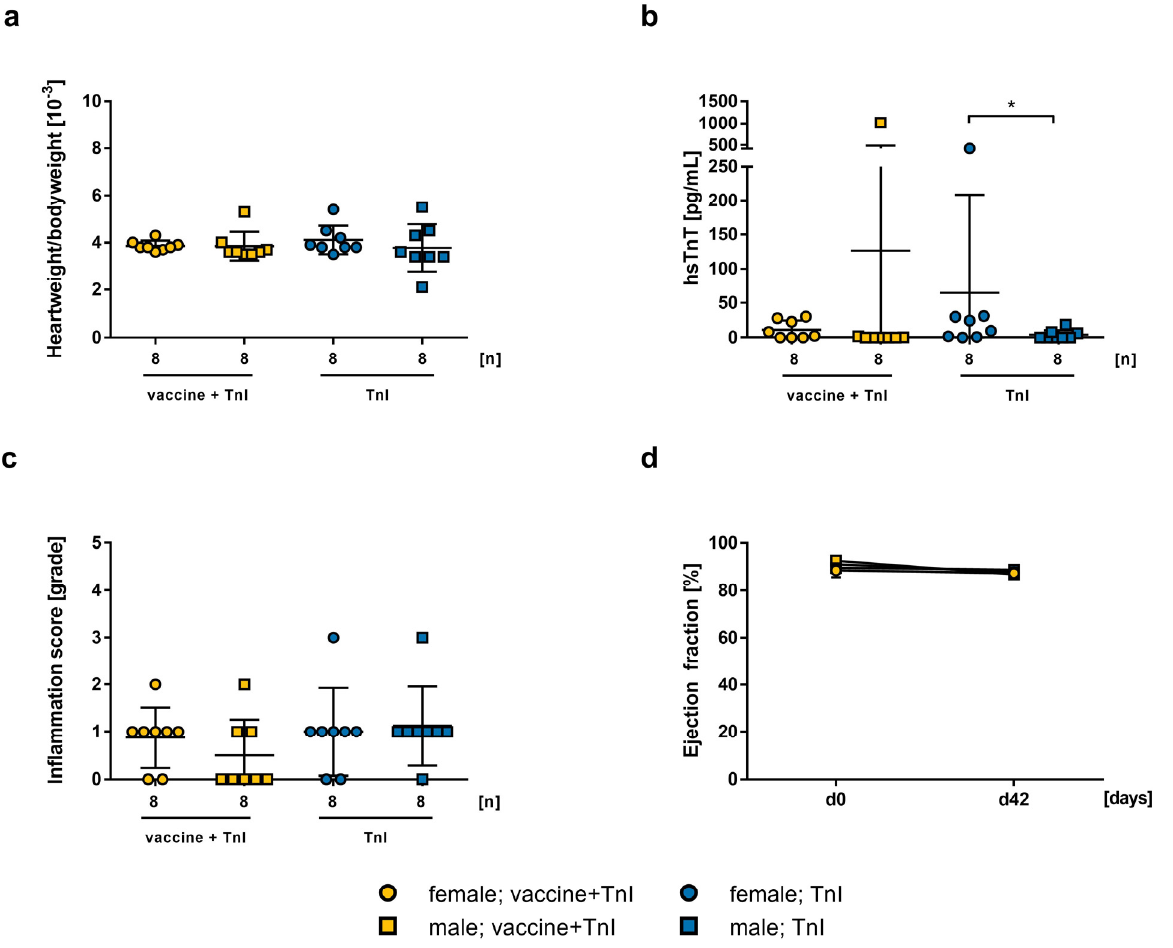
Figure 5. Effect of 2.5 µg mRNA-vaccine on the induction of an experimental autoimmune myocar- ocarditis with 150 µ g TnI peptide in A/J mice (n = 8). Data is presented as a mean ± SEM. ( a ) Cal- ditis with 150 µg TnI peptide in A/J mice (n = 8) . Data is presented as a mean ± SEM. ( a ) Calculated culated heart weight to body weight ratio on day 42. ( b ) Determination of hsTnT-levels in heart weight to body weight ratio on day 42 . ( b ) Determination of hsTnT-levels in mouse serum collected on day 42 . Statistical significance was determined by Mann–Whitney: * p = 0.0373. ( c ) His-